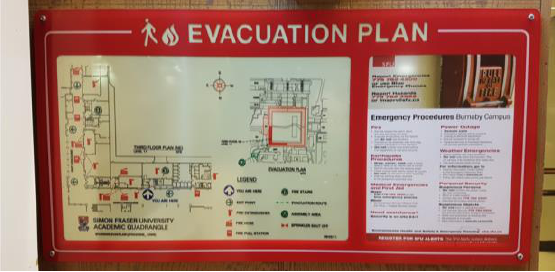
Figure 4. An example of the existing evacuation plan